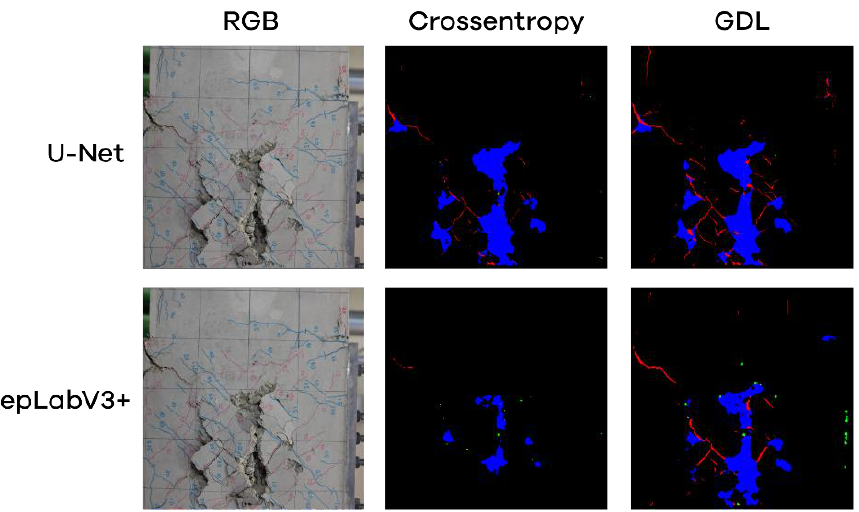
Figure 16. U-Net and DeepLabV3+ comparison on fine-grained object